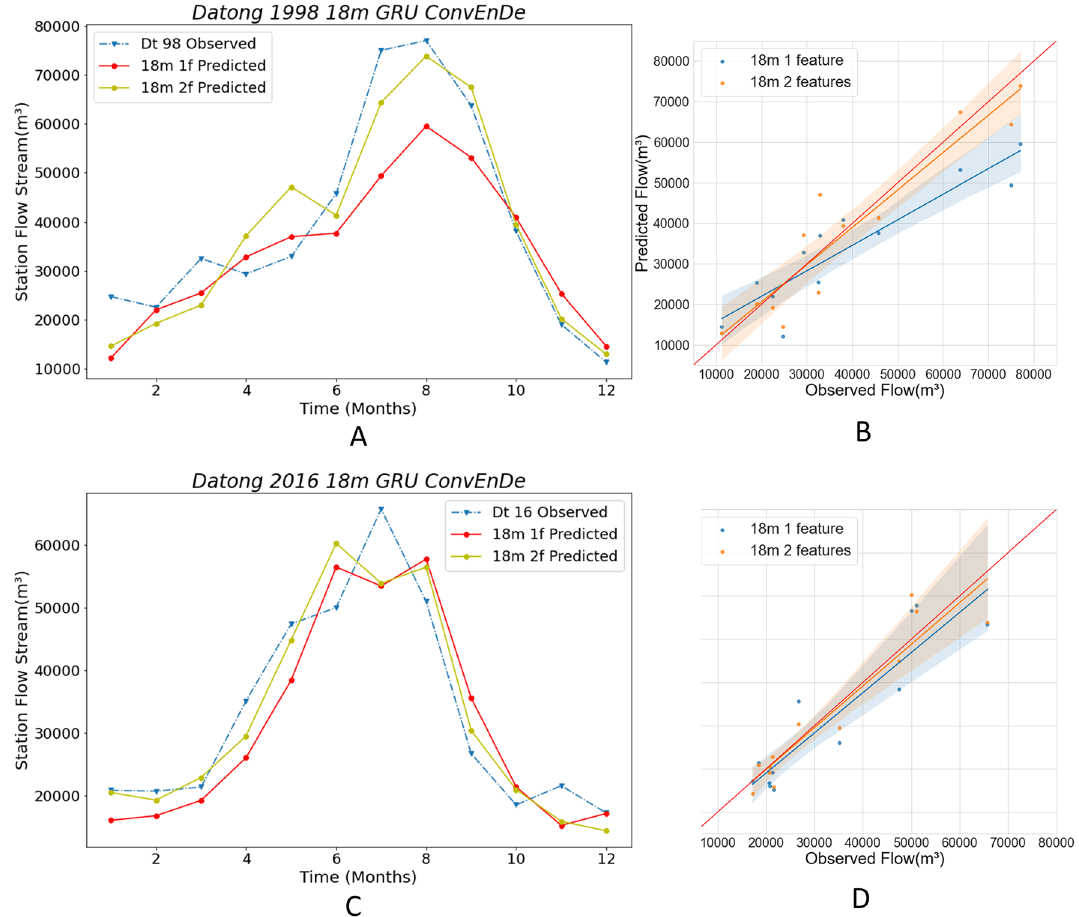
Figure 17. Comparison with different models in Datong station. The solid lines in A, C plot the predicted values using different numbers of feature data, and the blue dashed lines are the observed values. ( B, D ) The scatter plots corresponding to A, C .